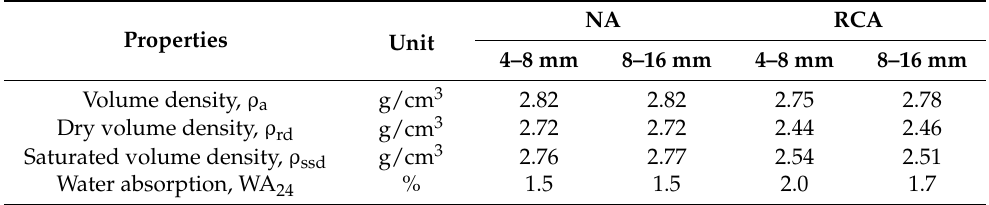
Table 1. The properties of the NA and RCA.